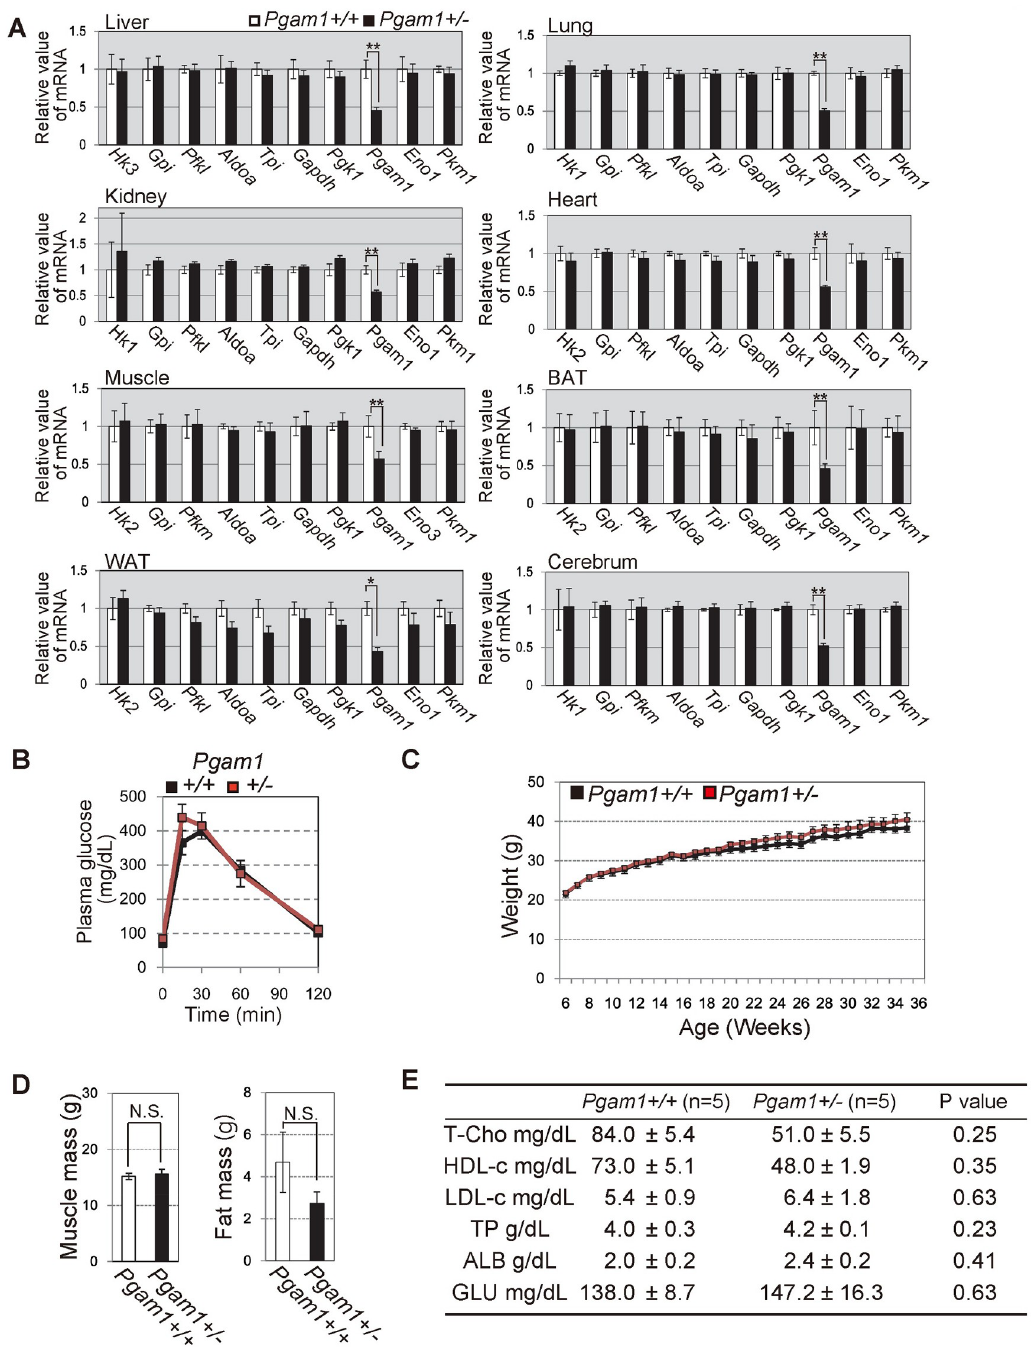
Fig 3. Characterization of Pgam1 heterozygous KO mice. (A) The comparison of glycolytic mRNAs profiles between wild-type and Pgam1 +/− mice. The extracts from indicated tissues were tested. (B) Intraperitoneal glucose test (IPGTT) was performed in wild-type (n = 5) and Pgam1 +/− mice (n = 4). (C-E) Several physiological parameters in wild-type (n = 5) and Pgam1 +/− mice (n = 5). (C) Body weight were measured every week for 30 weeks. (D) Measurements of muscle mass and visceral-fat mass by computerized tomography at 35 weeks. (E) Total cholesterol (T-Cho), high-density lipoprotein cholesterol (HDL-c), low-density lipoprotein cholesterol (LDL-c), Total protein, (TP), albumin (ALB) and blood glucose (Glu) were determined in the blood plasma of 35 weeks mice. +/+; wild-type, +/-; heterozygous knockout. Data represent the mean ± SEM. Single-asterisks ( � ) and double-asterisk ( �� ) indicate statistical significance of p < 0.05 and p < 0.005, respectively, Student’s t-test.